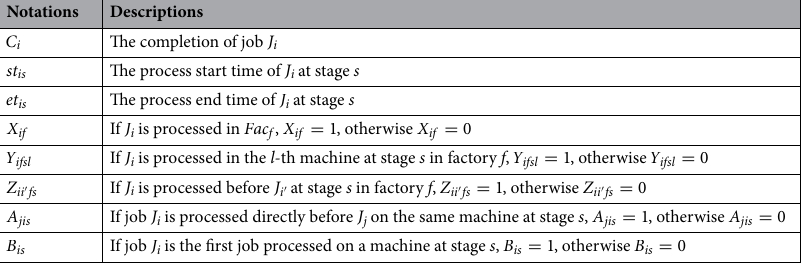
Table 1. Notations and